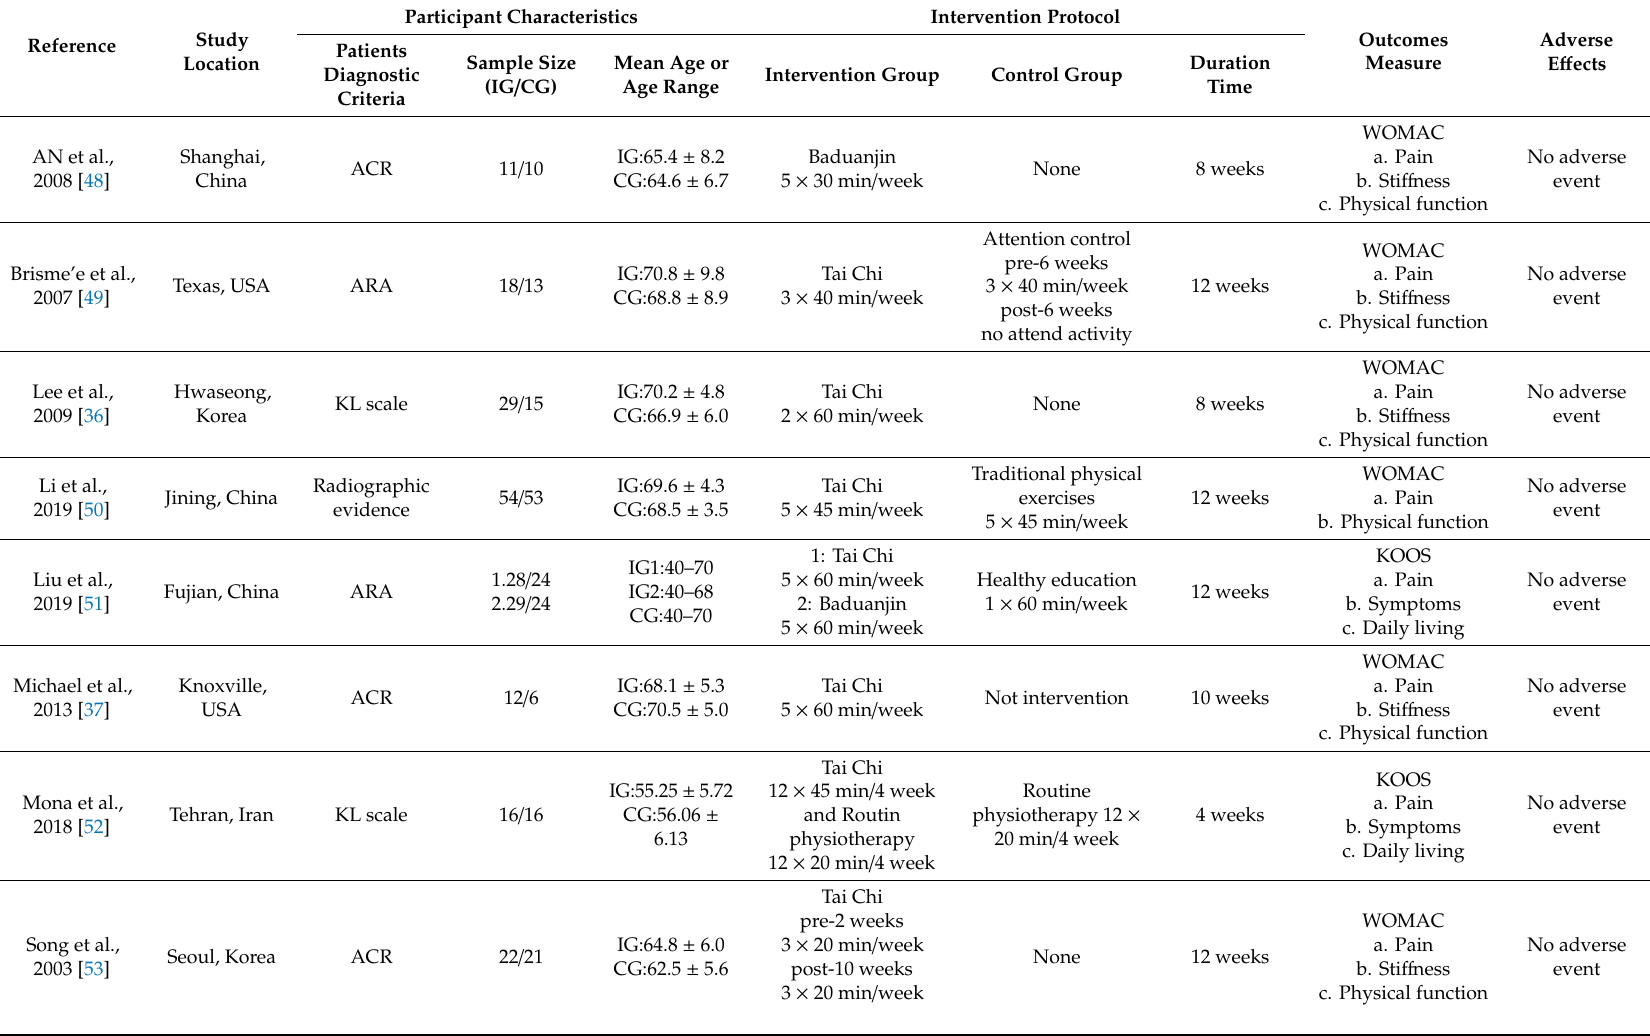
Table 1. Characteristics of data extracted from the included